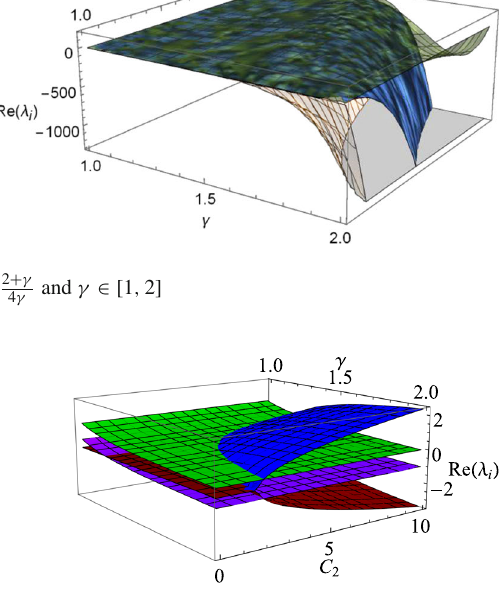
Fig. 8 Real part of the eigenvalues λ i for the equilibrium